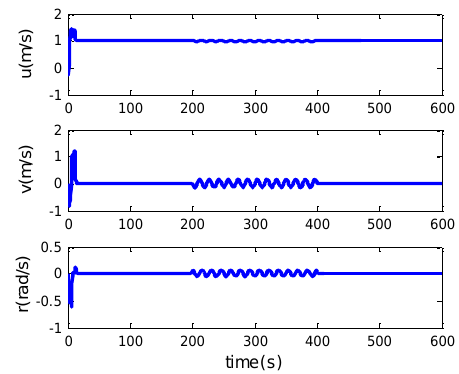
Figure 9. Trajectory tracking of AUVs using the FFTC